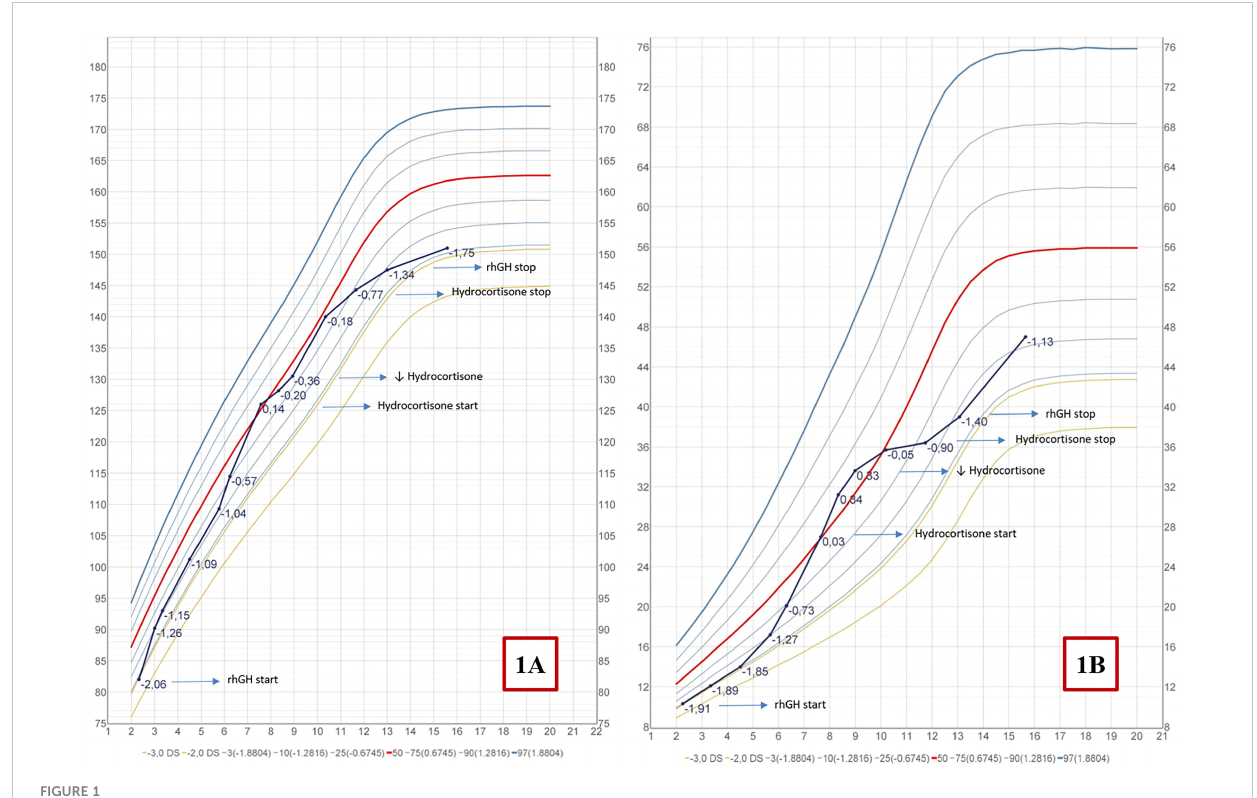
FIGURE 1 Italian growth chart for height (A) and weight (B)